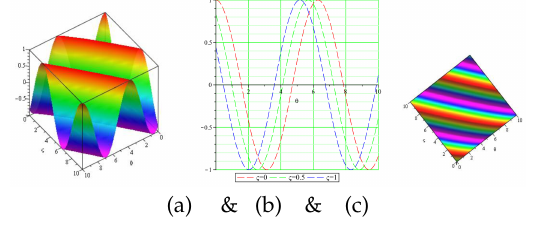
Fig. 3. 3D (left), 2D (middle) and contour (right) surfaces of real part Eq. (36) when µ = 0.9